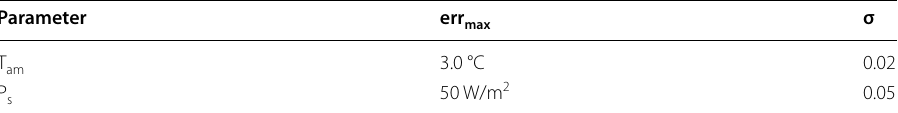
Table 2 Parameters of stochastic weather data